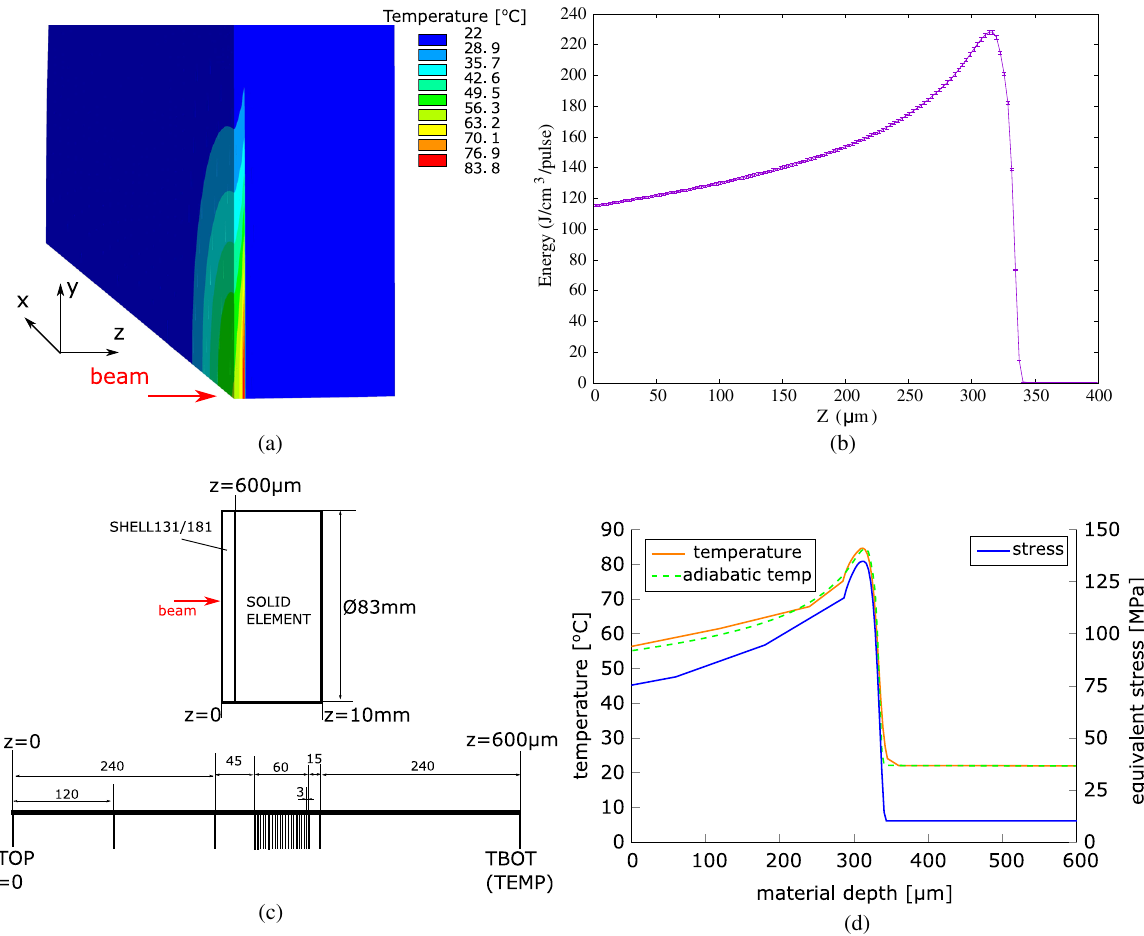
FIG. 6. (a) Through-thickness thermal distribution in a 10-mm-thick stopper out of the copper alloy CuCr1Zr after one extracted ion beam pulse from LEIR. Two symmetry planes are used. (b) Energy density deposited in the stopper along the beam axis. The energy deposition peaks at 320 μ m. (c) Layer distribution for the thermal and structural analysis. (d) Thermal and in-plane equivalent-stress distribution along the beam